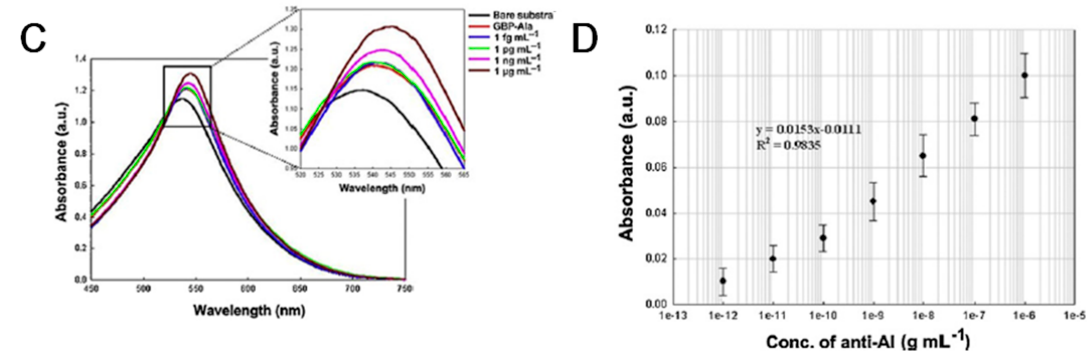
Figure 4. ( A ) Optical characteristics of multi-spot gold-capped nanoparticle array chip with localized-surface plasmon resonance (LSPR) absorbance peak: (1) slide glass substrate, (2) after gold deposition on slide glass substrate, (3) after silica nanoparticle array on the gold-deposited substrate, and (4) gold-capped nanoparticle array chip. Absorbance peak of multi-spot gold-capped nanoparticle array chip was observed at 540 nm. ( B ) Absorbance spectrum of LSPR properties obtained after binding of 100 µ g/mL gold binding peptide (GBP)–AIa with 1 µ g/mL anti-AI antibody in wavelength region (from 450 nm to 850 nm). LSPR properties of bare substrate (black line), GBP–AIa-immobilized on the multi-spot chip surface (red line), binding reaction between GBP–AIa and anti-AI antibody on the multi-spot chip surface (green line). Inset represents the 60 multi-spot gold-capped nanoparticle array chip with one spot of 2 mm in diameter. (For interpretation of the references to color in this figure legend, the reader is referred to the web version of the article). ( C ) Superimposed absorbance spectrum curves obtained from GBP–AIa immobilized on the surface of multi-spot chip in the presence of anti-AI antibody with concentrations ranging from 1 fg/mL to 1 µ g/mL. ( D ) Calibration curve